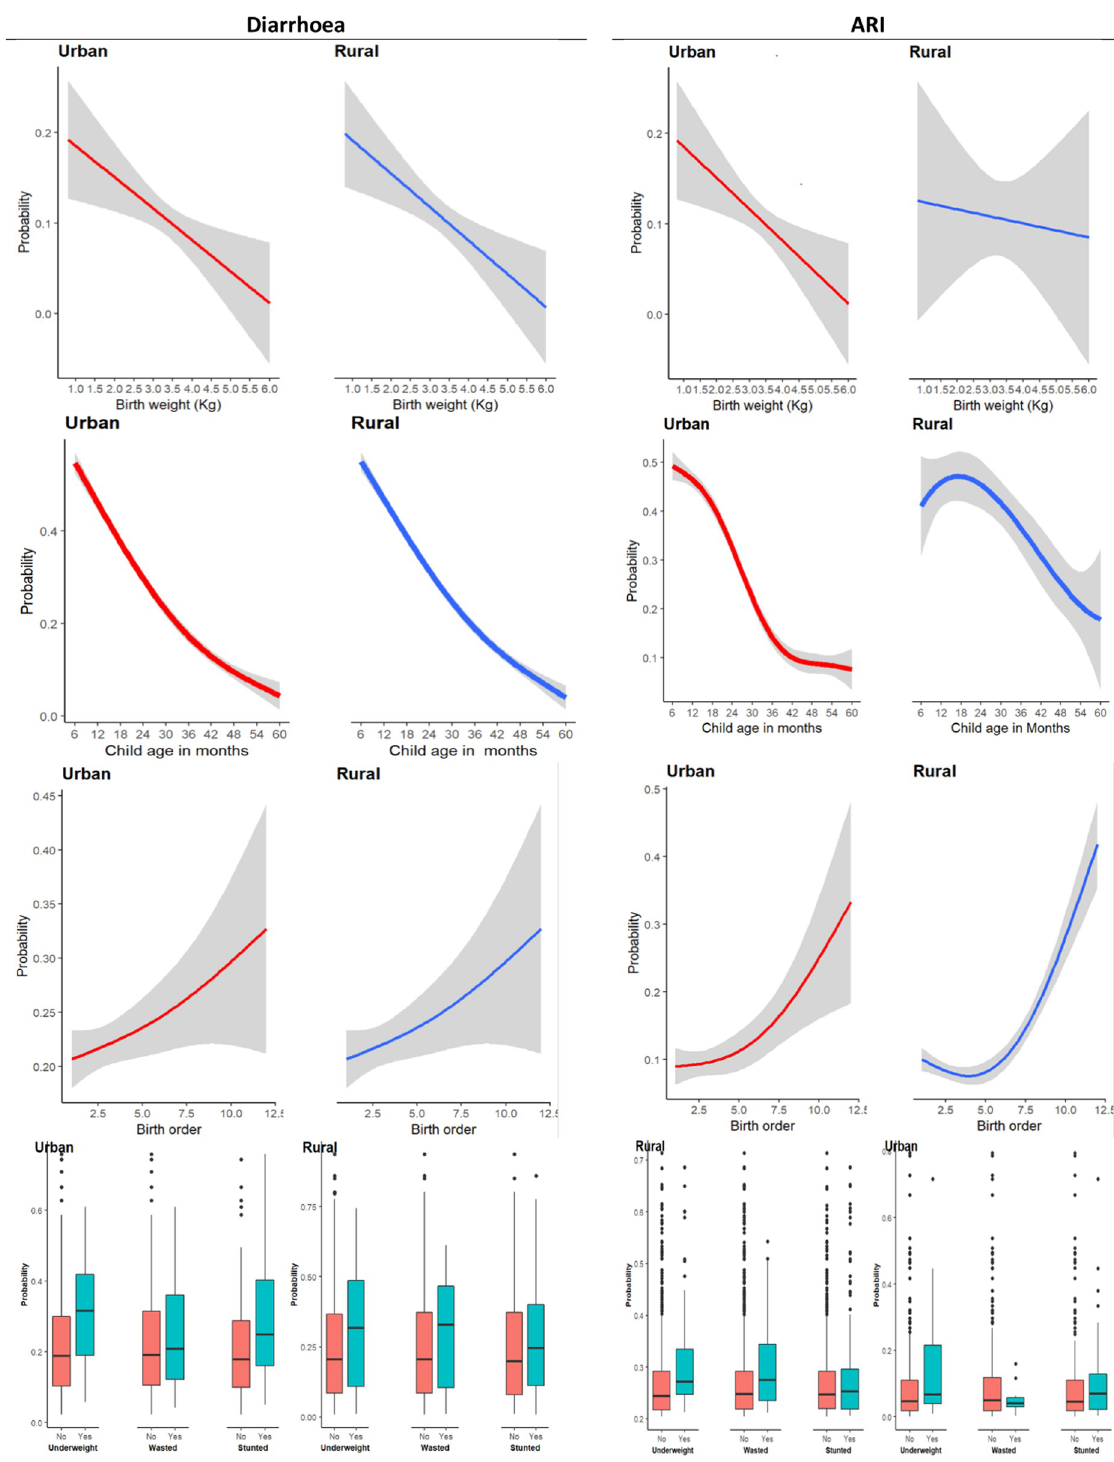
Fig 4. Association between children’s characteristics and child morbidities.